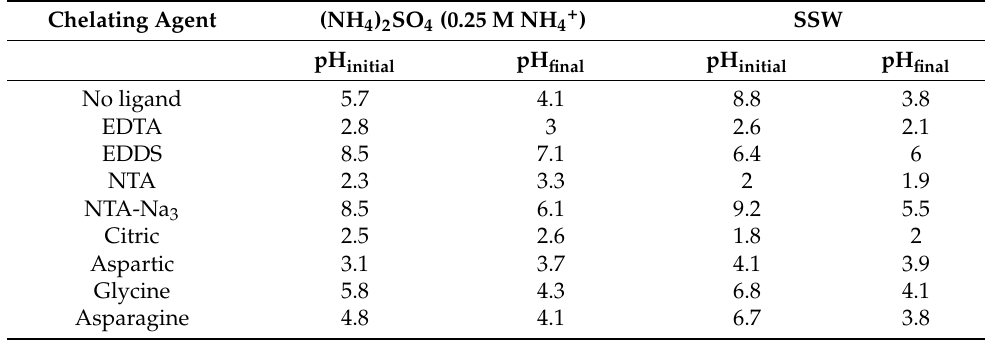
Table 5. Initial and final (equilibrium) solution pH